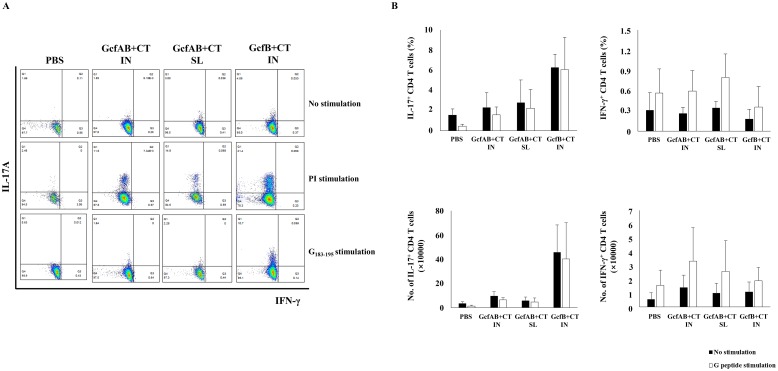
RSV B-specific Th1 and Th17-cell responses in GcfAB-immune mice after RSV B challenge.After RSV B (KR/B/10-12) challenge, all mice (n = 4/group) were sacrificed and lung mononuclear cells were isolated 5 days post-infection. Lung lymphocytes were stimulated and were analyzed as the same manner as in Fig 4. (A) CD3+ and CD4+ cells are shown in the dot plots, (B) and the percentage of such cells is represented as the frequency of RSV G-specific IFN-γ+ and IL-17A+ CD4 T cells. Data are represented in mean ± SD (n = 4/group). Significant differences are marked with a hash tag (#, p < 0.05).